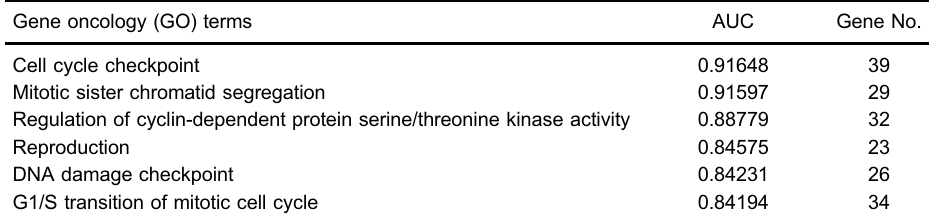
Table 3. List of optimal gene functions relying on area under the curve (AUC) 4